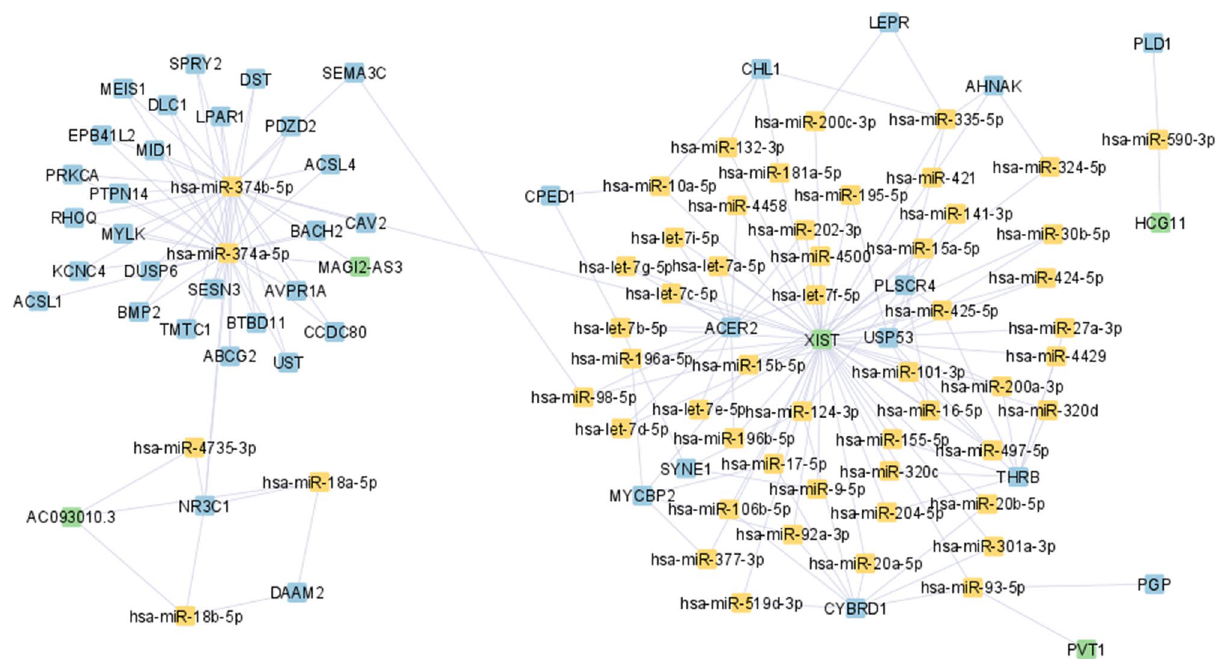
Figure 2. ceRNA network for stage II BC, was constructed by the Cytoscape tool 23